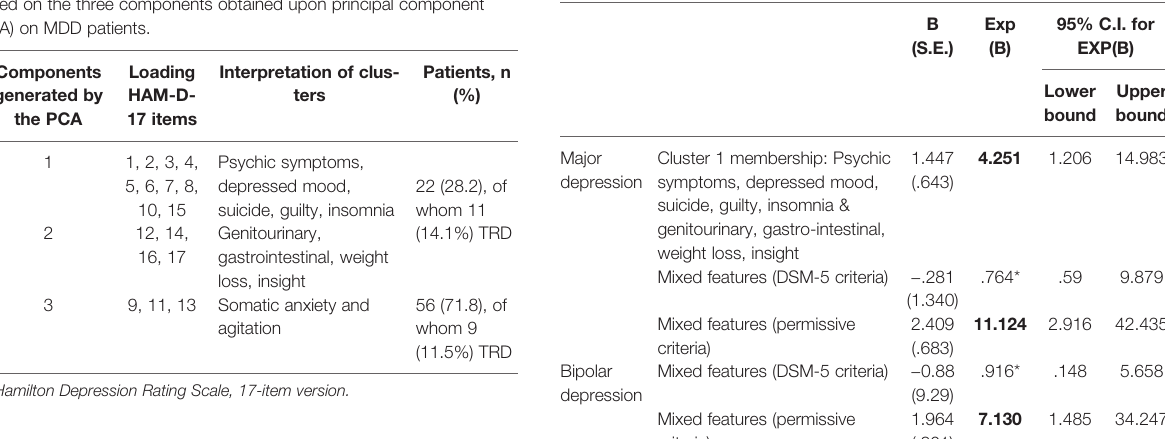
TABLE 6 | Binary logistic regression, signi fi cant predictors